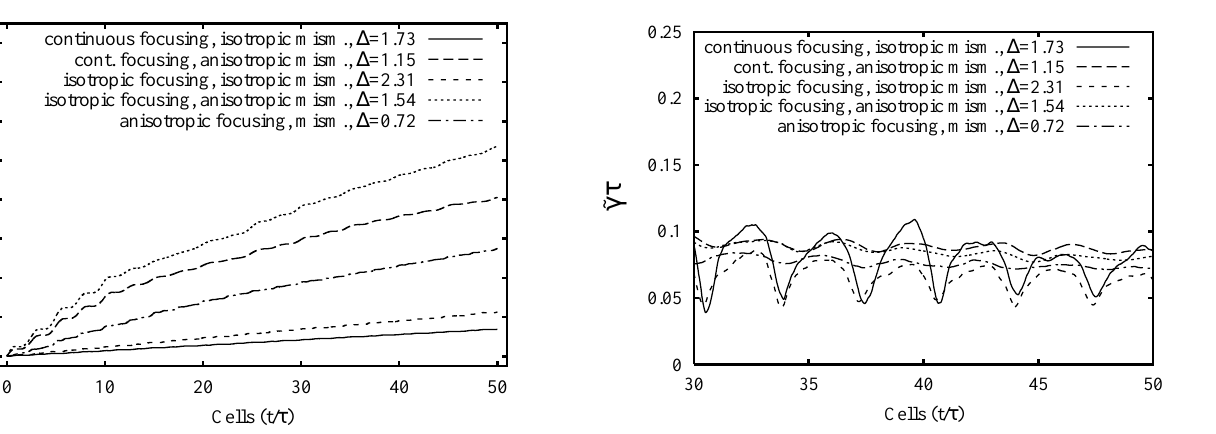
isotropic focusing, isotropic mism., ∆ =2.31 isotropic focusing, anisotropic mism., ∆ =1.54 anisotropic focusing, mism., ∆ =0.72